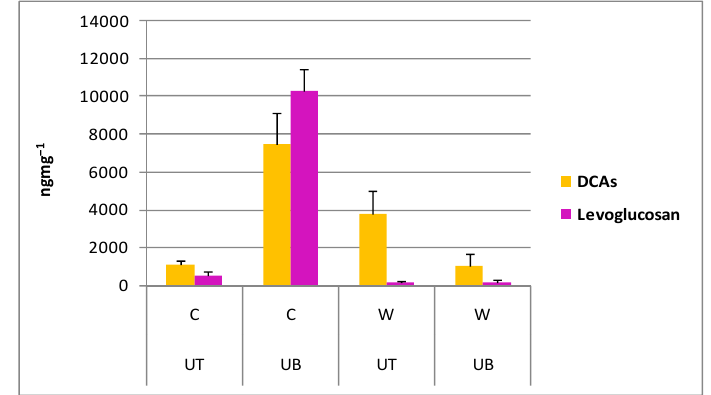
Figure 5. Mean ± SD of the content of polar organic marker compounds in the <0.49 μ m particle fraction (UT: urban traffic site; UB: urban background site; C: cold period; W: warm period).